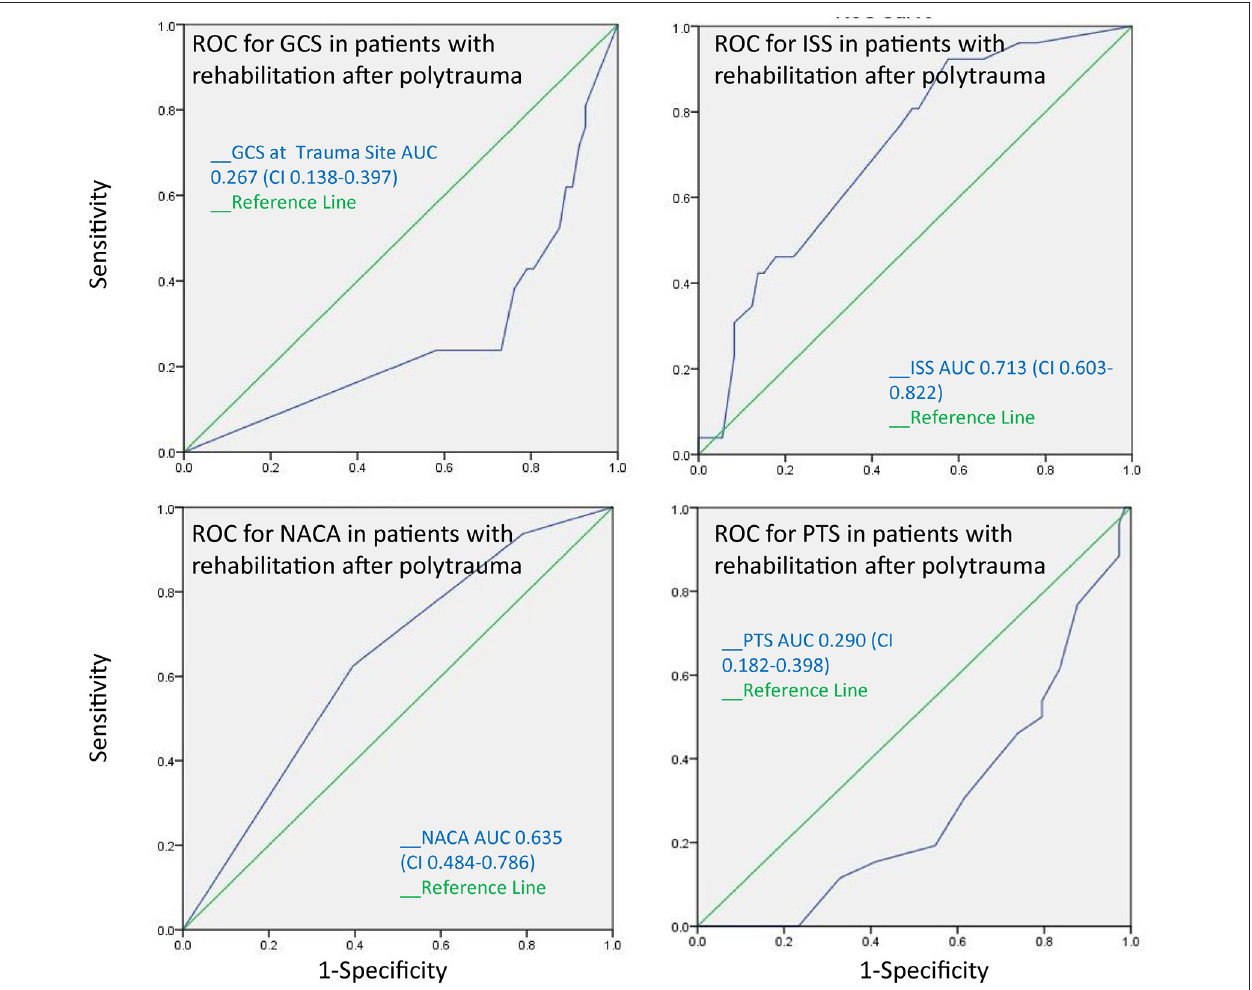
FIGURE 5 | The receiver operating characteristics curve for the need of rehabilitation after polytrauma indicates that the ISS and the NACA score can discriminate between patients whose injuries were severe leading to further rehabilitation measures after acute treatment and those who were able to be discharged home without additional